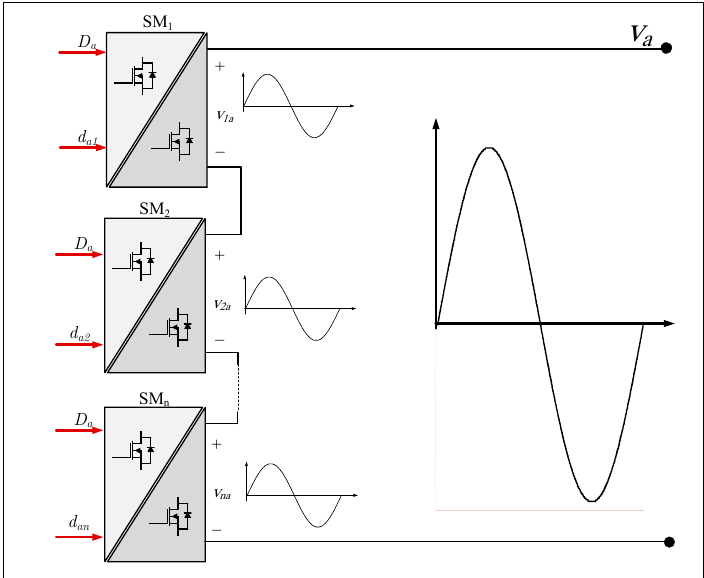
Figure 21. SM output voltages.